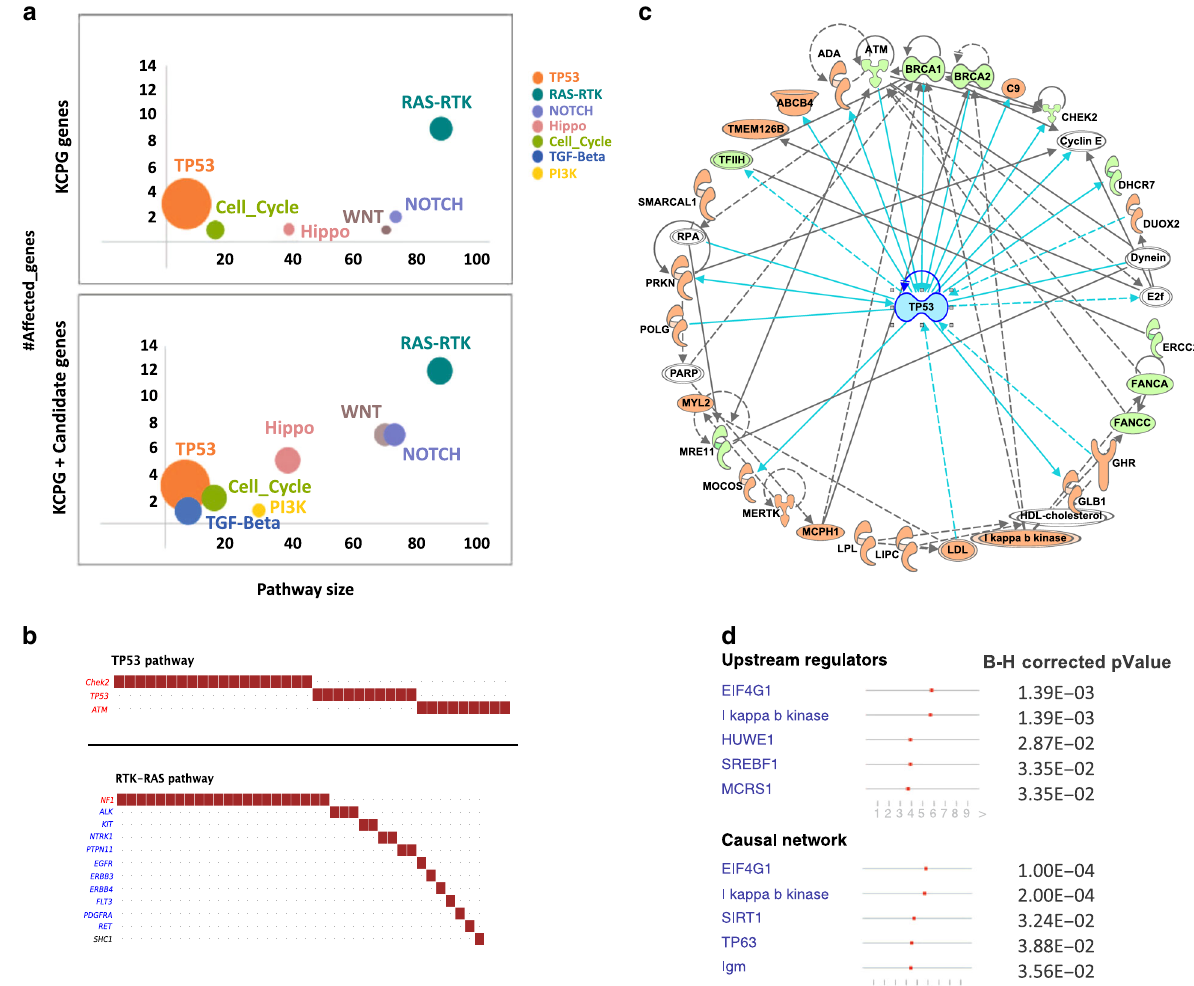
Fig. 4 Pathway analysis of altered genes with germline pathogenic/likely pathogenic (P/LP) variants in children, adolescents, and young adults (C-AYA) with solid tumors. a Affected pathways based on altered genes with P/LP germline variants. Top panel: only known cancer-predisposing genes (KCPG), lower panel: a combination of all KCPGs and candidate genes. Size of the circles increases as the fraction affected increases. b Genes mutated in TP53 (top panel) and RAS – RTK (lower panel) pathways, and the number of patients affected in our cohort. Red font: tumor suppressor genes; blue font: oncogenes. c Top network, predicted by Ingenuity Pathway Analysis (IPA), based on all the KCPG (green color) and candidate genes (salmon color) with at least four P/LP variants in our C-AYA patients with solid tumors (right-tailed Fisher ’ s exact test P = 1 × 10 − 42 ). d Eukaryotic Translation Initiation Factor 4 Gamma 1 (EIF4G1, B – H corrected P = 1.39 × 10 − 3 ) and I kappa b kinase (I κ B kinase, B – H corrected P = 1.39 × 10 − 3 ) predicted to be the top upstream regulators/causal network based on our IPA analysis. Right-tailed Fisher ’ s exact test was used, and Benjamini – Hochberg (B – H) P value correction performed to reduce the false discovery rate